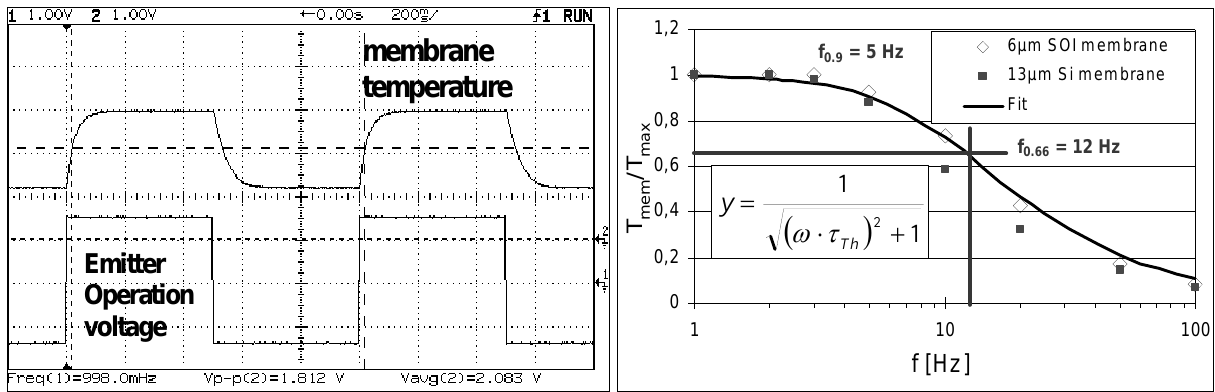
Figure 5. Modulation experiment as performed on an EM1 emitter. (Left) Response of the membrane temperature to 1 Hz square voltage pulses; (right) membrane temperature as a function of the excitation frequency. Thermal time constants are on the order of 15 ms.